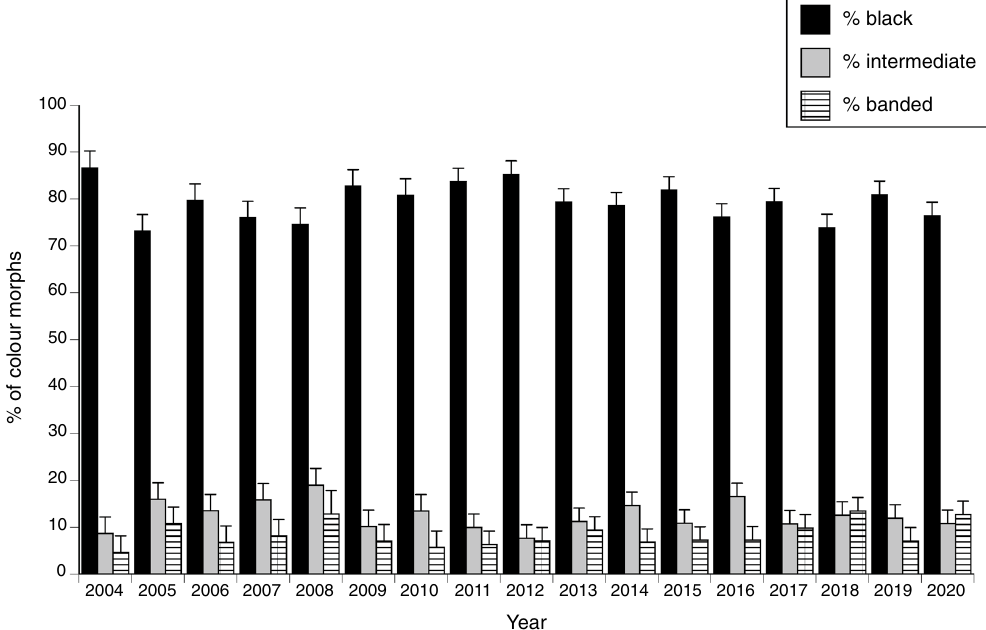
Figure 3. The proportion of snakes ( Emydocephalus annulatus ) belonging to each colour morph through time, based on annual surveys over an 18-year period. The graph shows mean annual values for the three study sites, with associated standard errors.